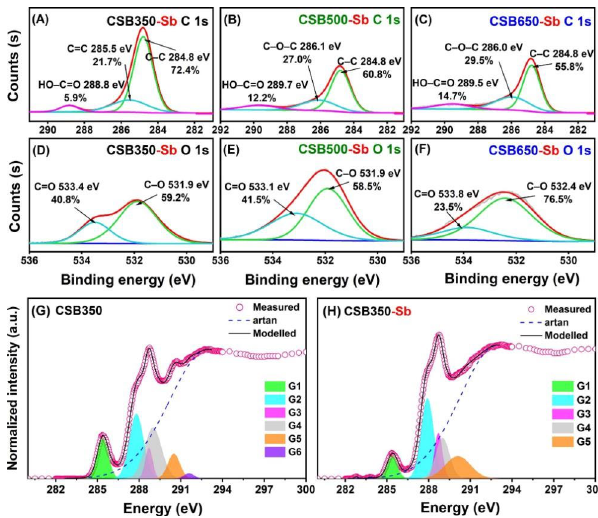
Fig. 7 XPS spectra of C 1s (A, B, C) and O 1s (D, E, F) for crawfish shell biochar (CSB) pyrolyzed at 350 ° C (CSB350), 500 ° C (CSB500), and 650 ° C (CSB650) after Sb(III) adsorption; Carbon K-edge NEX- AFS spectra of CSB350 (G) and Sb-laden CSB350 (H). G1-G6 repre- sent six Gaussian curves and Artan represents an arctangent step func- tion. All deconvolution results are listed in Table